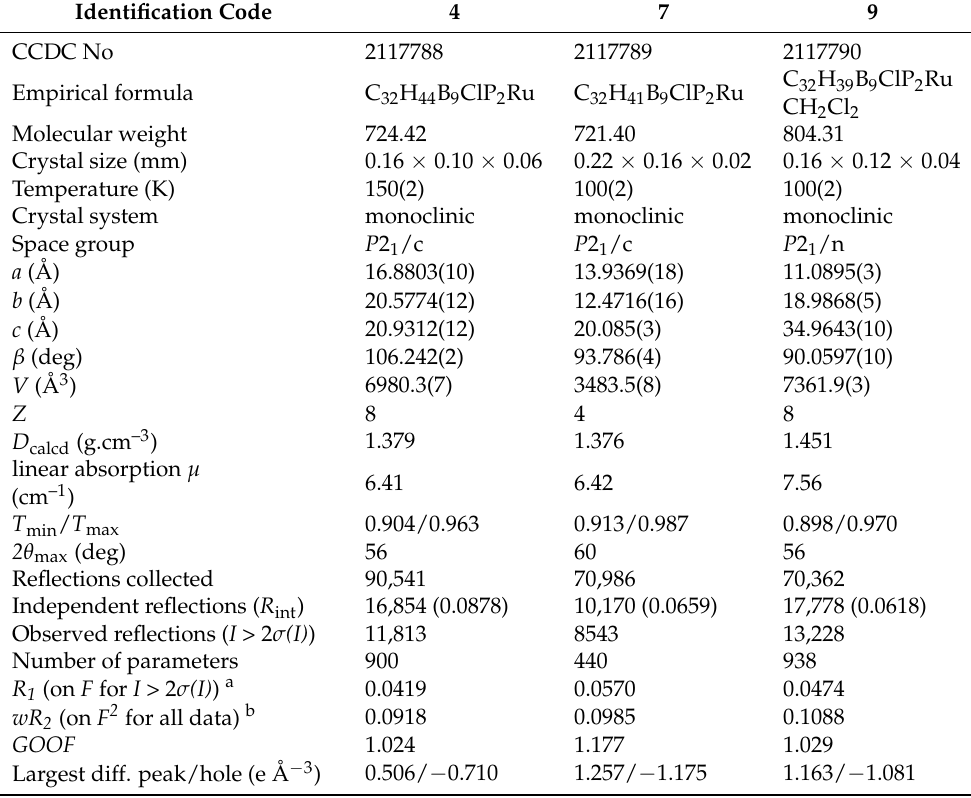
Table 4. The crystal data, data collection and structure refinement parameters for ruthenacarboranes 4, 7, 9